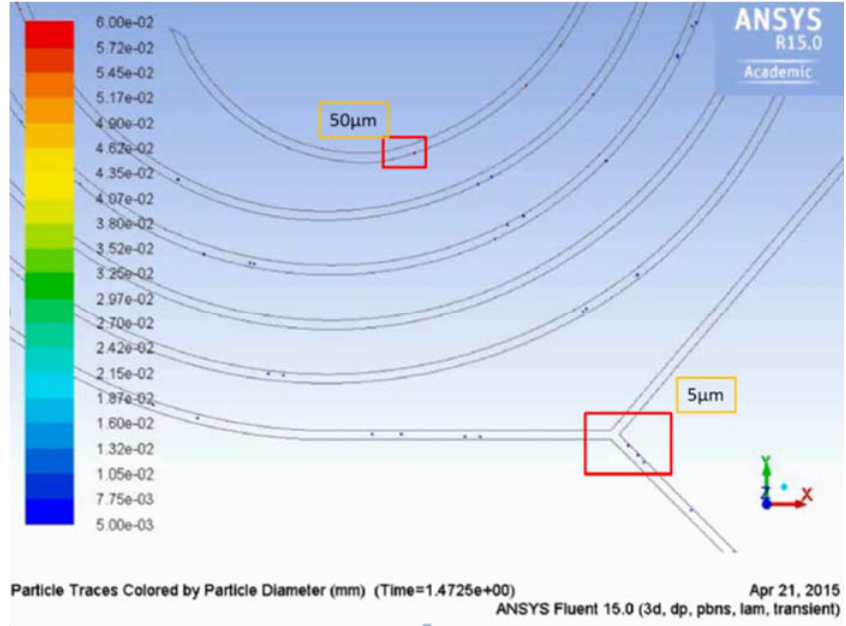
Figure 7. The simulation photo, where the red dots represent 50 µm particles and the blue dots represent 5 µm particles.